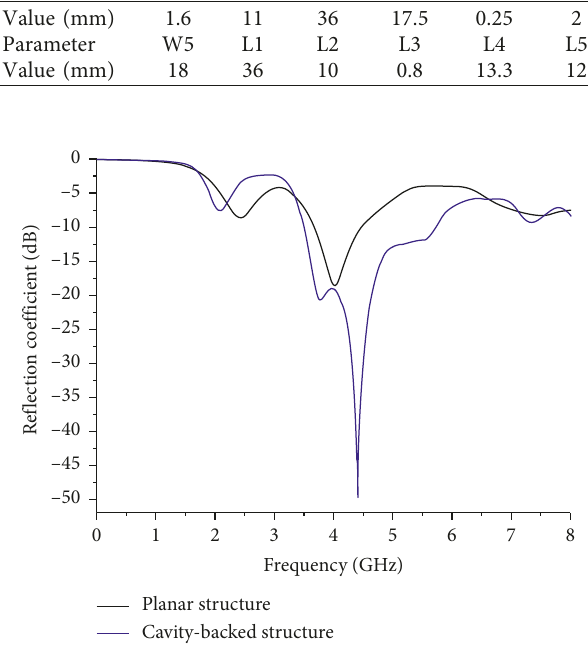
Figure 2: Simulated reflection coefficient in free-space of the planar and cavity-backed antennas.